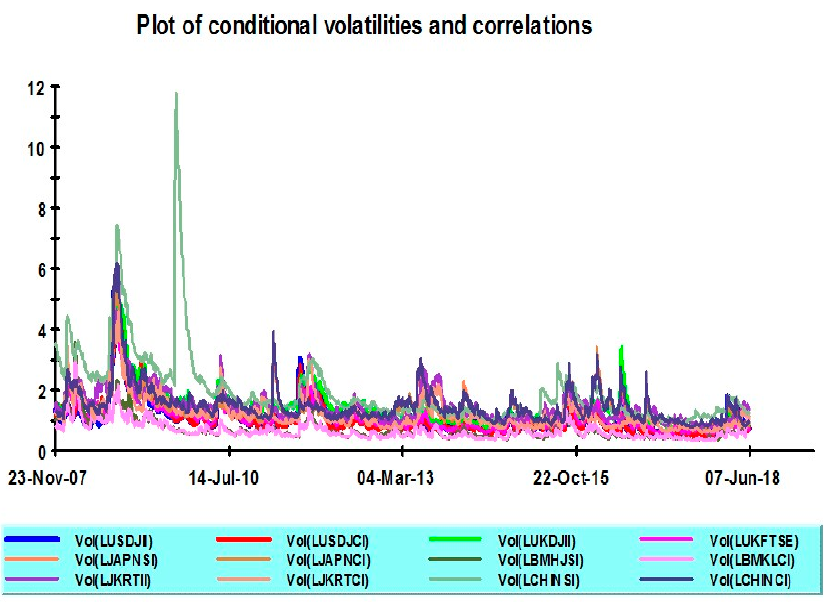
Figure 4. Conditional volatility.